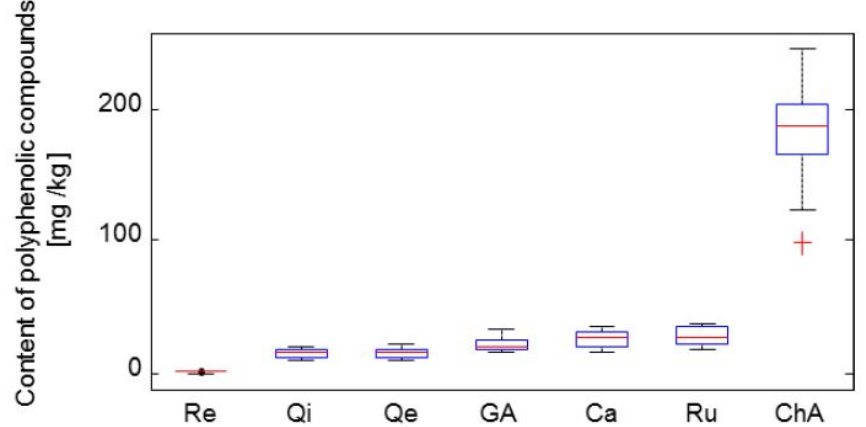
Figure 3. Box plot graphs demonstrating the rate of dispersions of individual methods